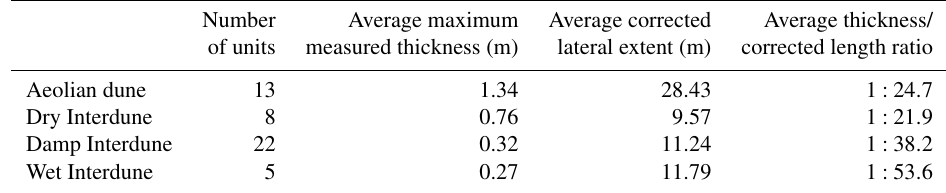
Table 3. Measurements taken from Frodsham Marsh Borehole core with estimates of lateral extent using calculated ratio. All Minimum Maximum Average Minimum Maximum Average measurements Number measured measured measured calculated calculated calculated in (m) of units thickness thickness thickness lateral extent lateral extent Aeolian Dry Interdune Damp